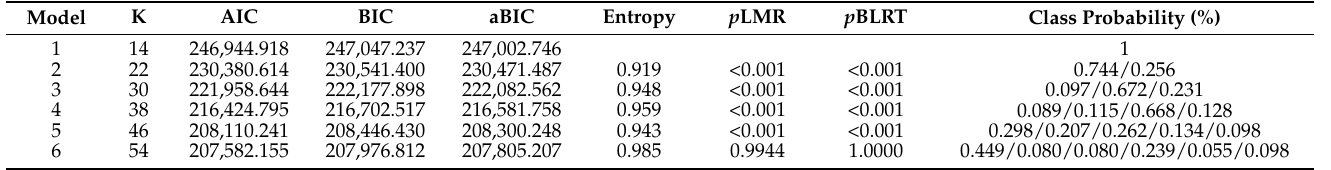
Table 1. Potential profile model fit metrics for media